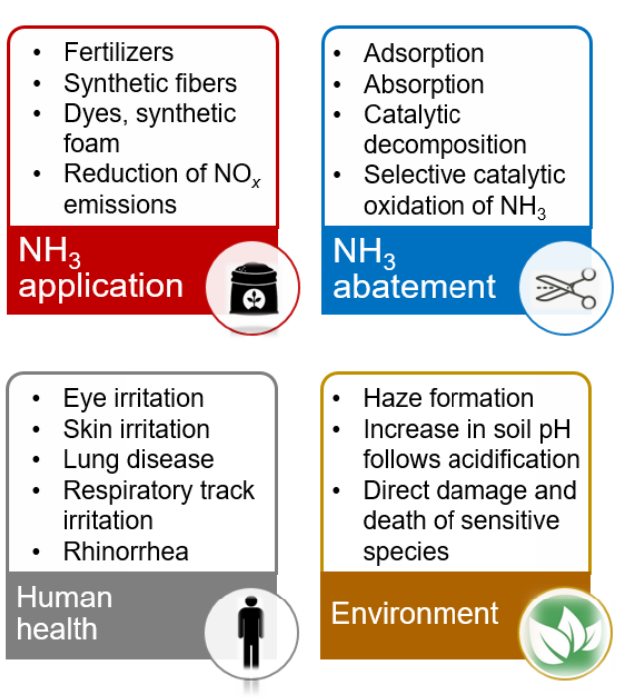
Figure 1. Schematic representation of NH 3 application and abatement, as well as the impact of NH 3 on human health and the environment.